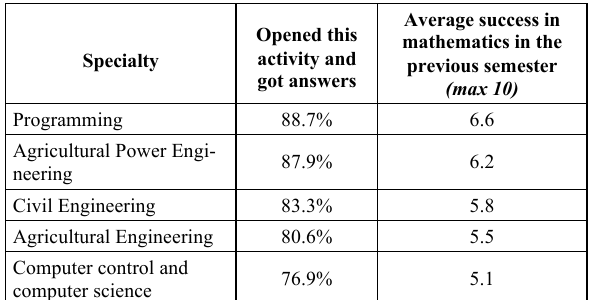
Figure 7. Proportion of self-directed studies in e- environment